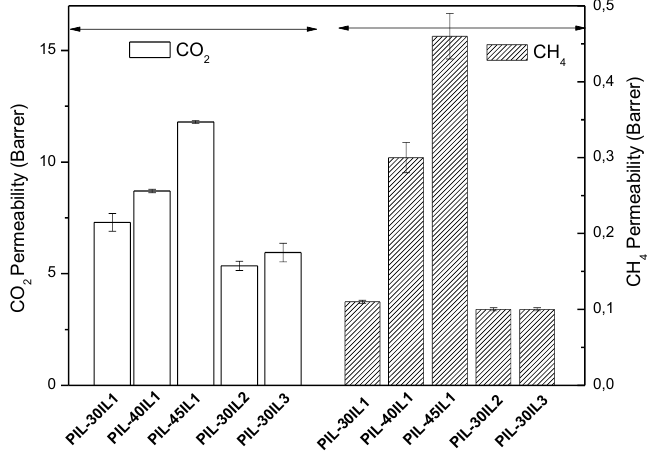
Figure 9. CO 2 and CH 4 single gas permeabilities of the prepared PIL-IL composite membranes at room temperature.